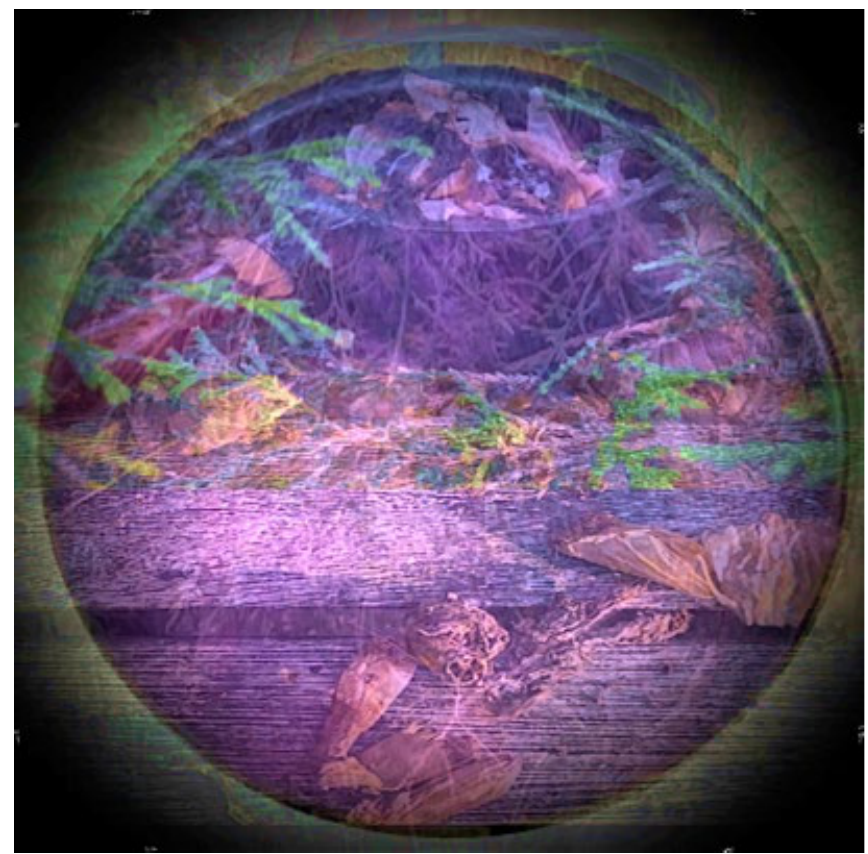
Figure 3 . Sacred Circle, Medicines and